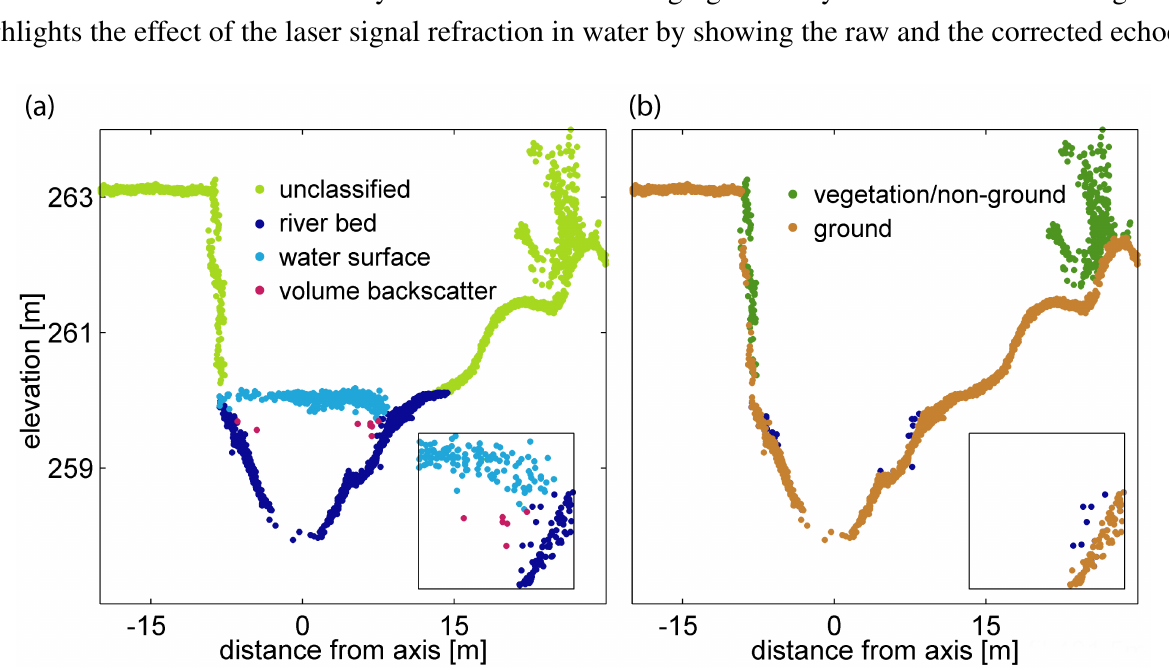
Figure 8. Classified LiDAR points; ( a ) pre-classification of water echoes (water surface, volume backscatter, river bed); ( b ) DTM filtering (ground,